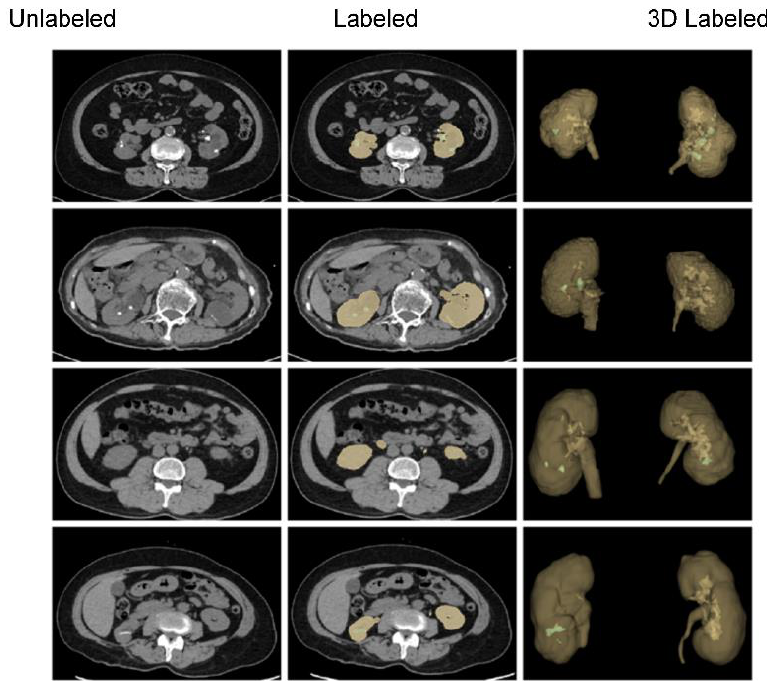
Figure 1. A few of the samples in both 2D and 3D from our annotated dataset of unenhanced abdominal CT images (kidney: yellow; kidney stone: green).